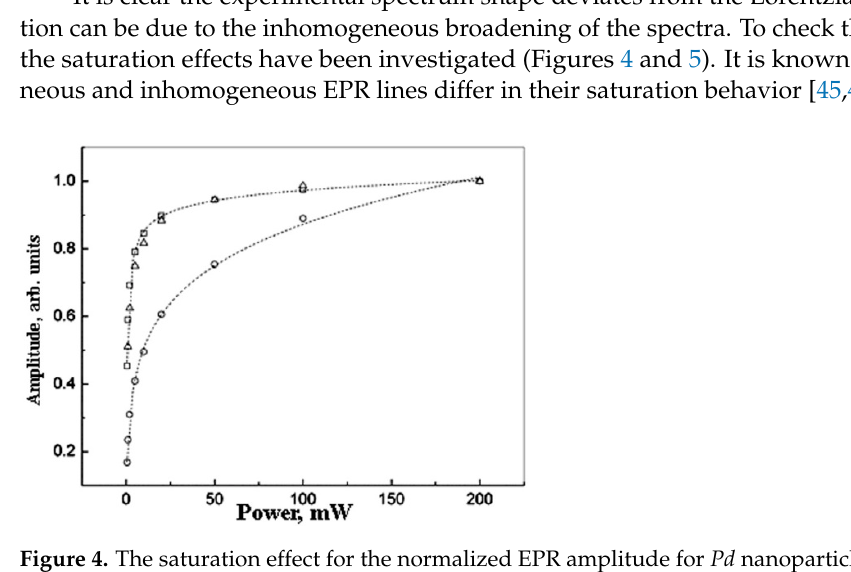
Figure 5. Linewidth saturation curves for experimental EPR spectra for the Pd nanoparticles in polyethylene for the concentrations of 5 wt.% ( ○ ), 10 wt.% ( □ ), and 20 wt.% ( ∆ ). The do tt ed line showed the approximation by formulae (4) for 5 wt.%. The amplitude saturation law is near equal for samples with Pd content 10 wt.% and 20 wt.% (Figure 4). This law can be written [45] as follows: 𝐴 = 𝐶(cid:3493)𝑃(cid:4666) 1 + 𝑃 𝑃 (cid:2868) . (cid:2873) ⁄ (cid:4667) (cid:3029) / (cid:2870)